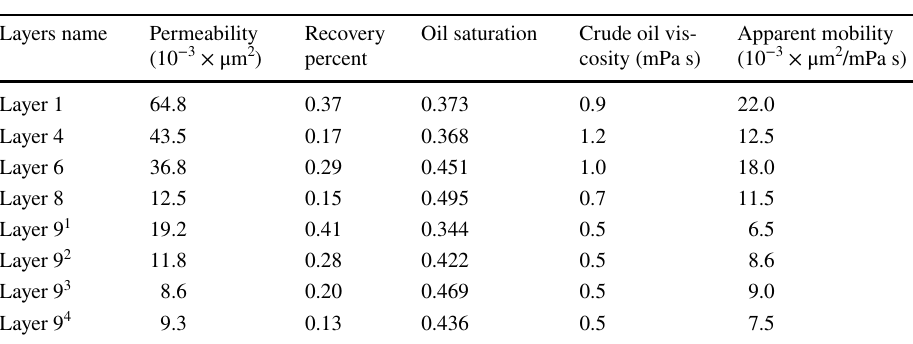
Table 1 Parameters of Block Five of Bonan oilfield